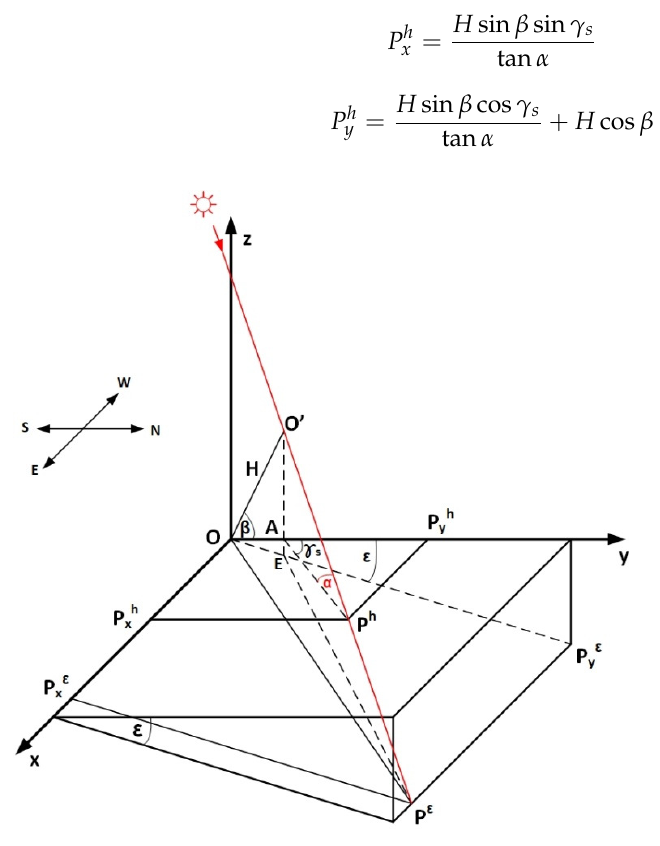
Figure 6. Shadow components of an inclined pole β on a horizontal plane at point P h and on a southern sloped plane at point P ε